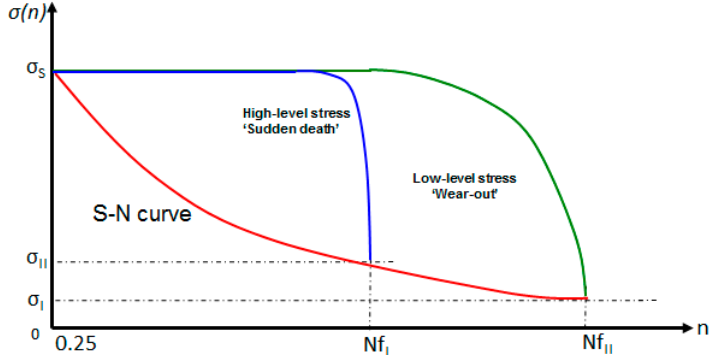
Figure 3. The sudden death and wear out model for the power law fit used in Shokrieh’s